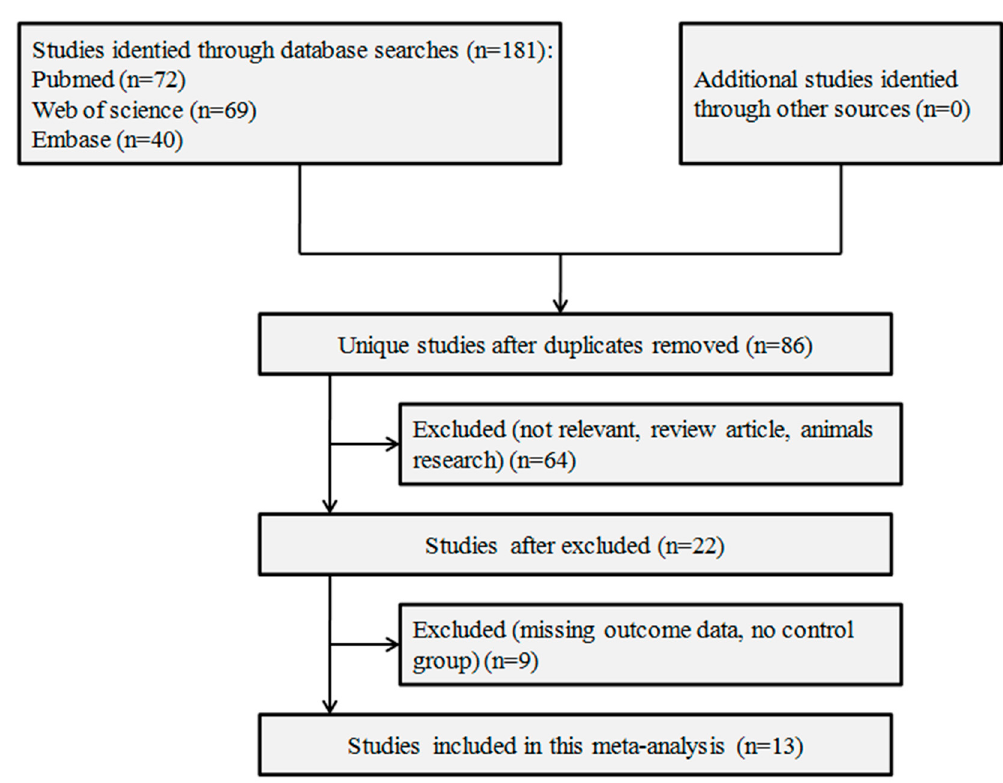
Figure 1. Study selection flow chart.